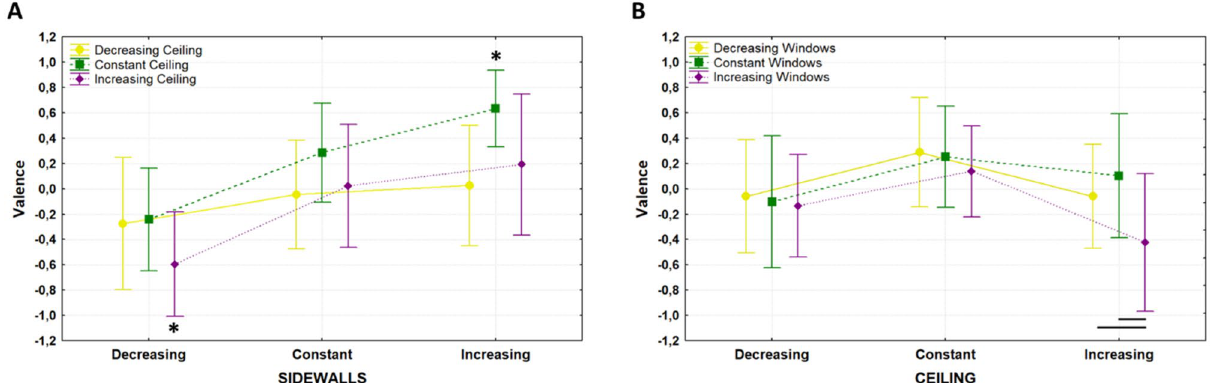
Figure 3. ( A ) distribution of the valence scores for the two-way interaction SideWalls × Ceiling. Yellow, green, and purple lines represent decreasing, constant, and increasing ceiling height. ( B ) distribution of the valence scores for the two-way interaction Ceiling × Windows. Yellow, green, and purple lines represent decreasing, constant, and increasing windows height. Data are presented with their mean value with vertical lines representing the 95% confidence interval. Black lines stand for significant pairwise comparison, while black asterisks remark an experimental condition that all comparisons with the other conditions are significant.